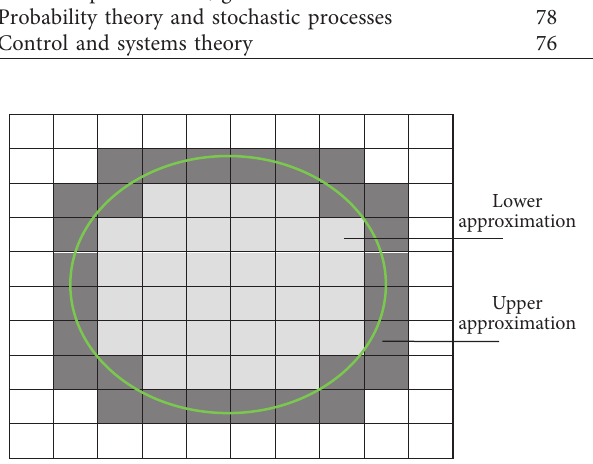
Figure 14: Concept of rough